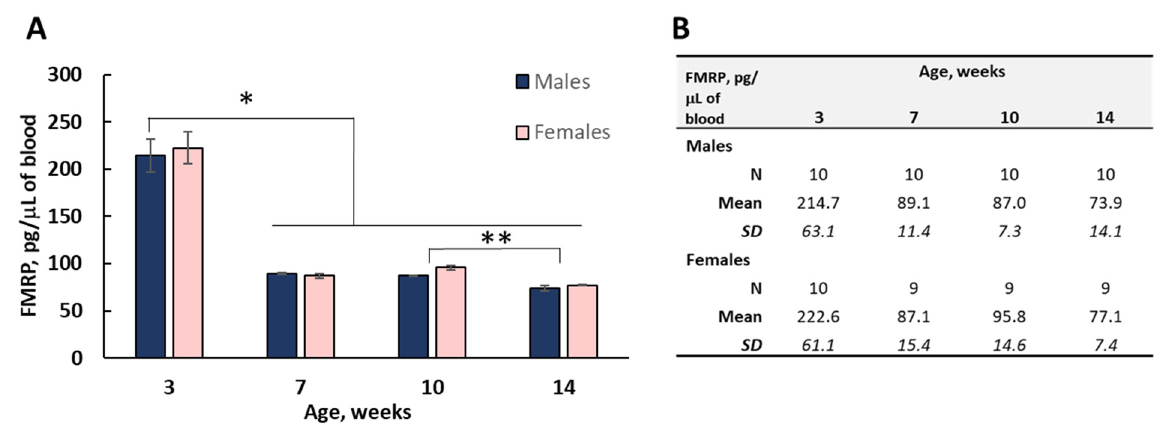
Figure 5. Quantitative assessment of FMRP in DBS extracts derived from C57BL/6J mice. A bar graph representation of the levels of FMRP detected in DBS extracts from male and female mice collected at 3, 7, 10, and 14 weeks of age is shown in ( A ). FMRP presented as gram per unit volume (10 − 12 g/mL) of whole blood as listed in part ( B ). FMRP levels detected in DBS of the 3 week old animals were significantly higher (* p < 0.001) compared to the data at 7, 10, and 14 weeks of age. FMRP expression in 14 week old mice vs. 10 week old mice was significantly lower in both sexes (** p < 0.05 for males and p < 0.01 for females). Error bars represent the SEM of the group.